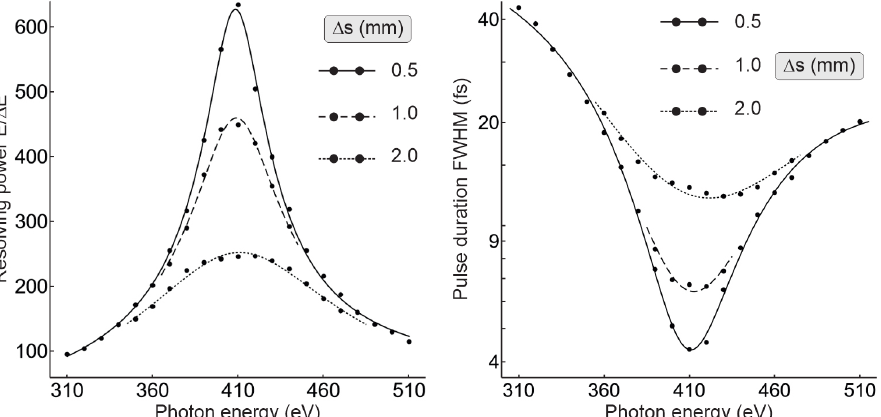
Figure 6. Spectral resolving power ( left ) and pulse duration ( right ) of the TDCM as a function of the photon energy at three values for the reflective stripe width ∆ s , in each case for a source size of 50 µ m (FWHM). Ray-tracing data (dots) follow the nonlinear fit model (solid, dashed and dotted lines) from Equation (5). Toward off-design energies, the curves coincide asymptotically, with reduced plots for